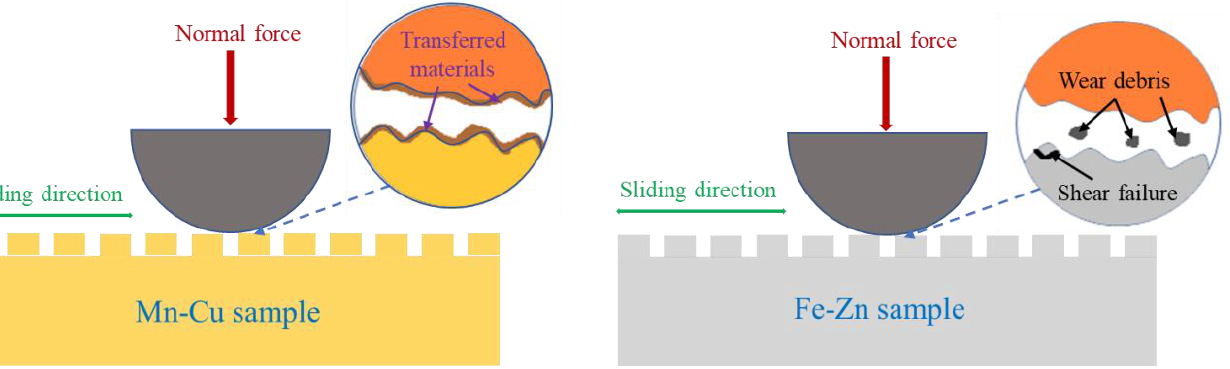
Figure 17. Schematic diagrams of wear mechanism under dry-sliding conditions of Mn-Cu and Fe-Zn woven samples.